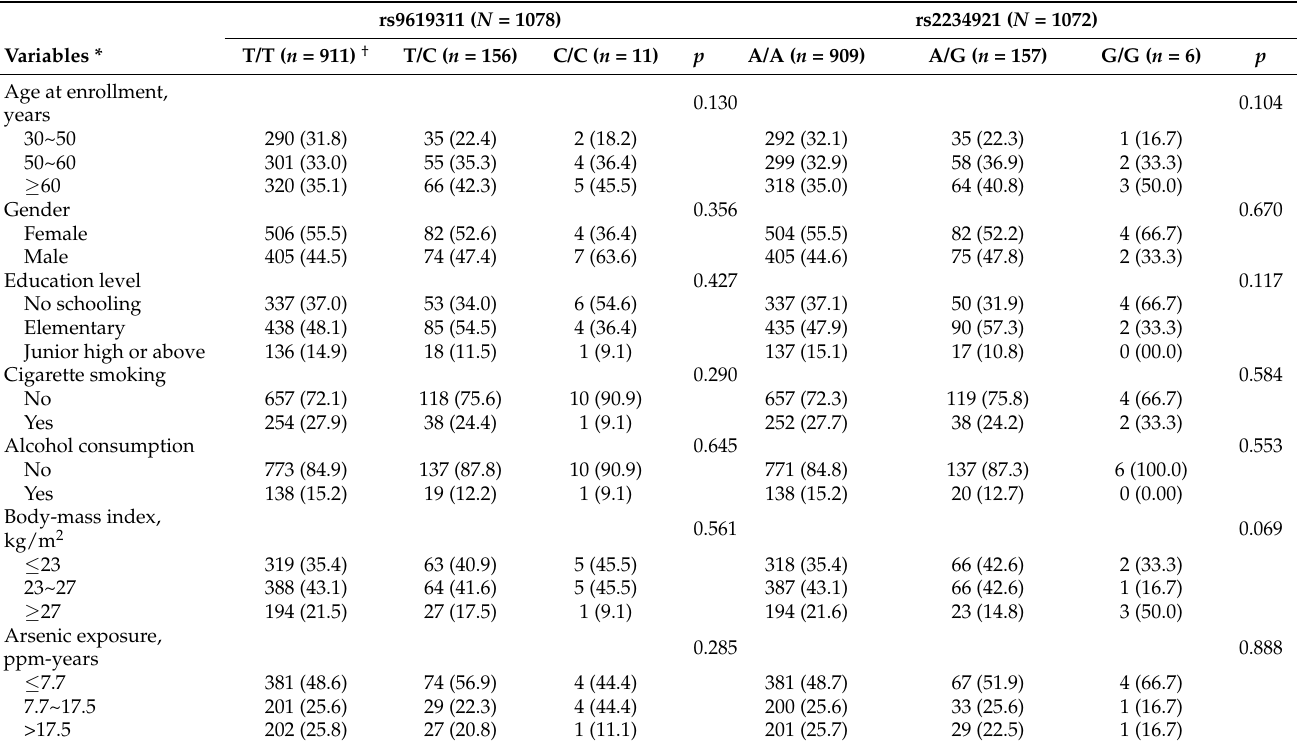
Table 1. Baseline characteristics of study participants across TIMP3 rs9619311 genotypes and rs2234921 genotypes.